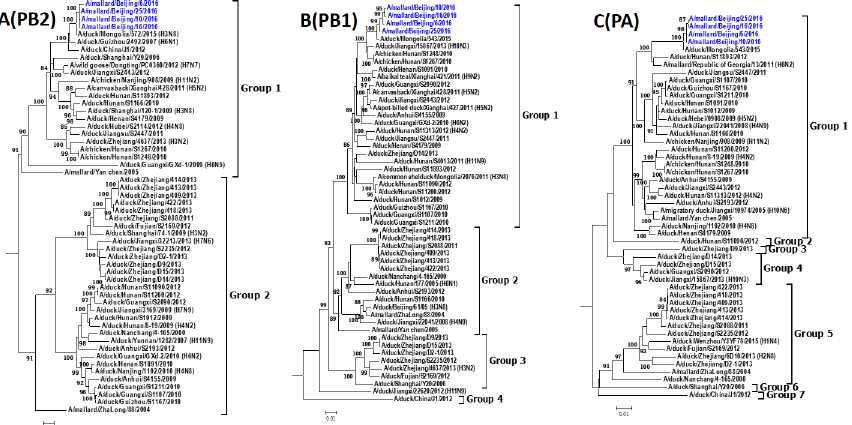
Fig 2. Phylogenetic trees of PB2 (A), PB1 (B) and PA (C) genes of H4N6 AIVs in China. Phylogenetic trees were generatedby the neighbor-joiningmethod and bootstrappedwith 1000 replicates using MEGA6. Analysis was basedon nucleotides1–2277of the PB2 gene, 1–2274of the PB1 gene, and 1–2151of the PA gene. Virus subtypes that are not H4N6are indicatedin brackets. Virus strains isolatedin this study are highlightedin